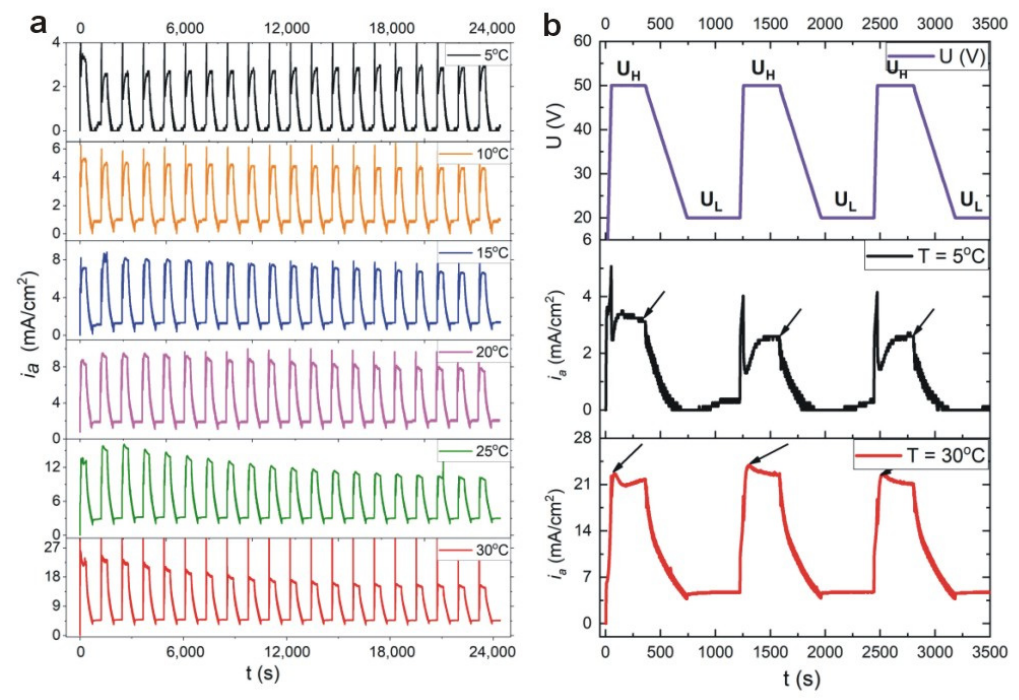
Figure 1. Current density ( i a )—time ( t ) transients during pulse anodization (20 cycles) of aluminum at temperatures 5–30 °C ( a ); first three U H - U L pulses along with the i a ( t ) curves for anodization at 5 °C and 30 °C ( b ). The black arrows in Figure 1b signify the i amax : depending on the type of anodization process (MA or HA) the i amax value was determined at the end or the beginning of the U H pulse. The unequal current recovery indicates that the total amount of charge in each U H pulse decreases as the number of pulses increases. Since the thickness of anodic alumina is directly proportional to the net amount of charge involved in anodization reaction, it is thus expected that thickness. Thickness of three initial and final segments (corresponding with the first and last potential pulses in the 20-cycle anodization process) formed under U H and U L potentials (d H and d L , respectively) for PAA produced at the two extreme temperatures is presented in Figure 2. As can be seen, the difference between initial and final d H and d L segments is much larger in the PAA-based DBR formed at 30 °C as compared to that formed at 5 °C.